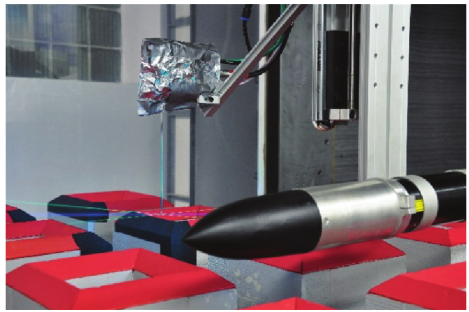
Figure 3: The configuration of the FFID (left) and LDA (right) probes mounted on the traverse system in the wind